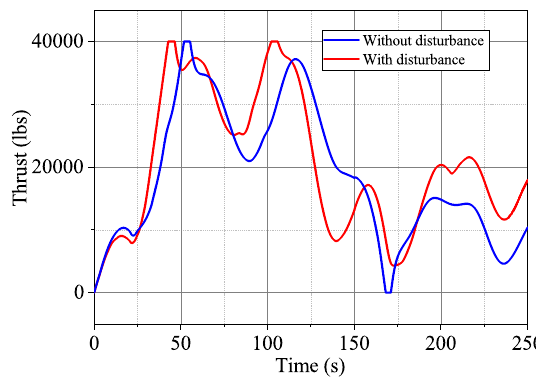
Figure 12. Thrust.